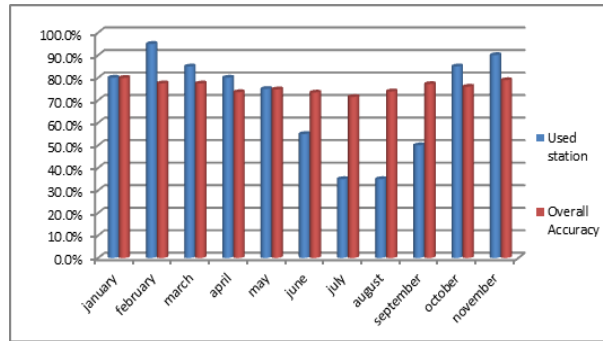
Figure 3. Comparison charts between stations and